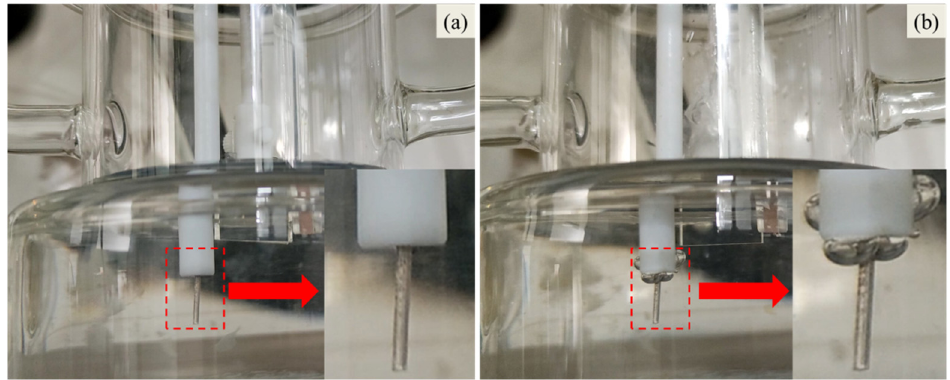
Figure 6. The picture of the OER on the anode surface at pressures of ( a ) 80 kPa and ( b ) 3 kPa.